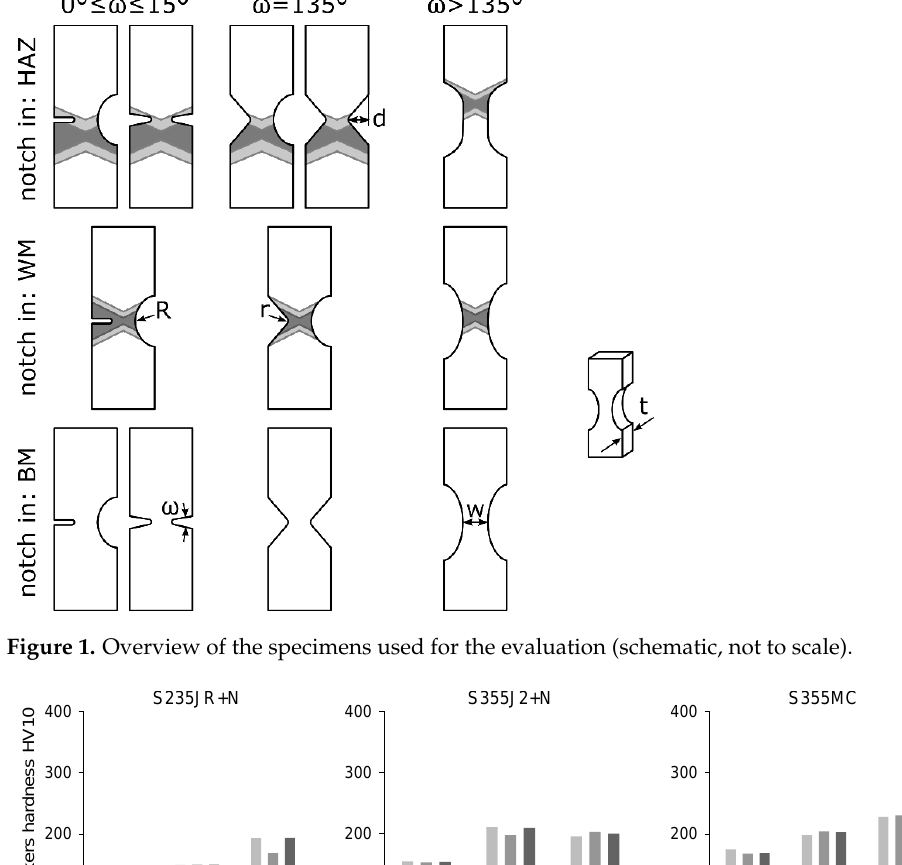
Figure 1. Overview of the specimens used for the evaluation (schematic, not to scale).